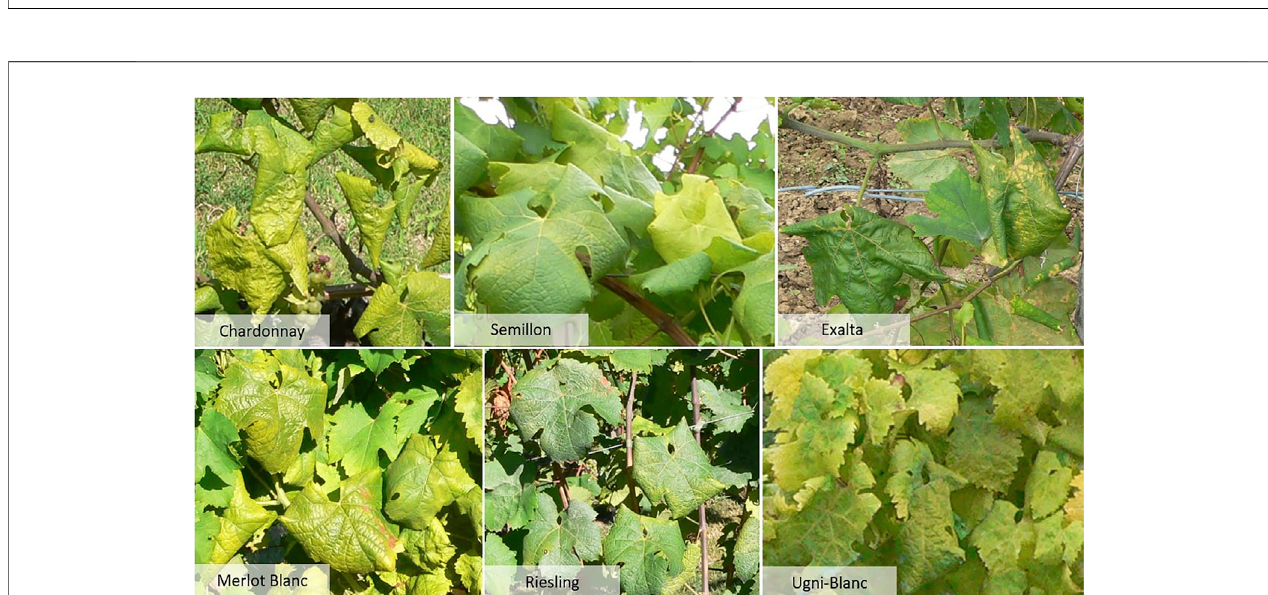
FIGURE 2 | Illustration of Flavescence dorée symptoms for the different grape varieties found in the Ext. test dataset. Source: D. Vergnes, FREDON Aquitaine.